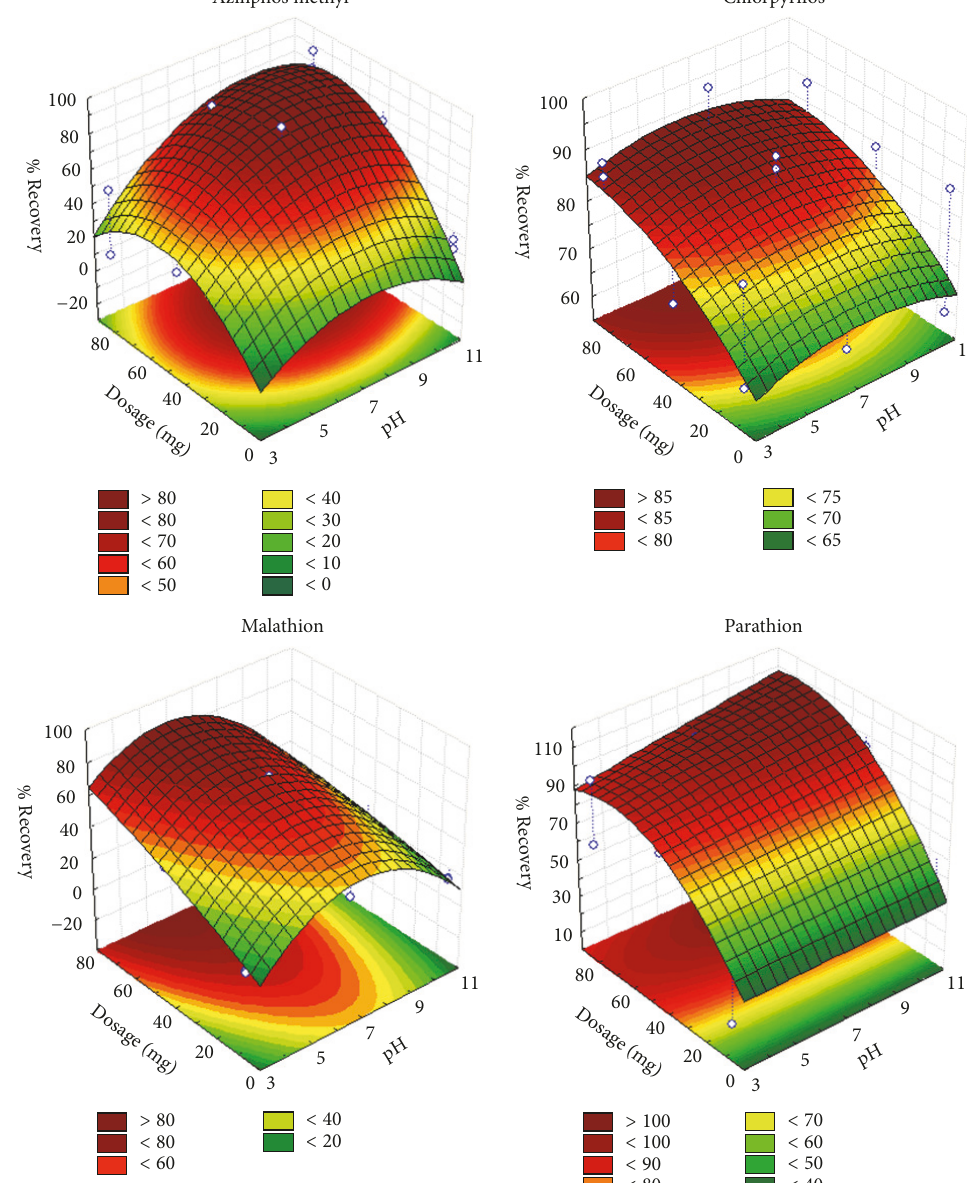
Figure 6: Surface response generated from a quadratic model in the optimization of pH and adsorbent dosage for azinphos methyl, chlorpyrifos, malathion, and